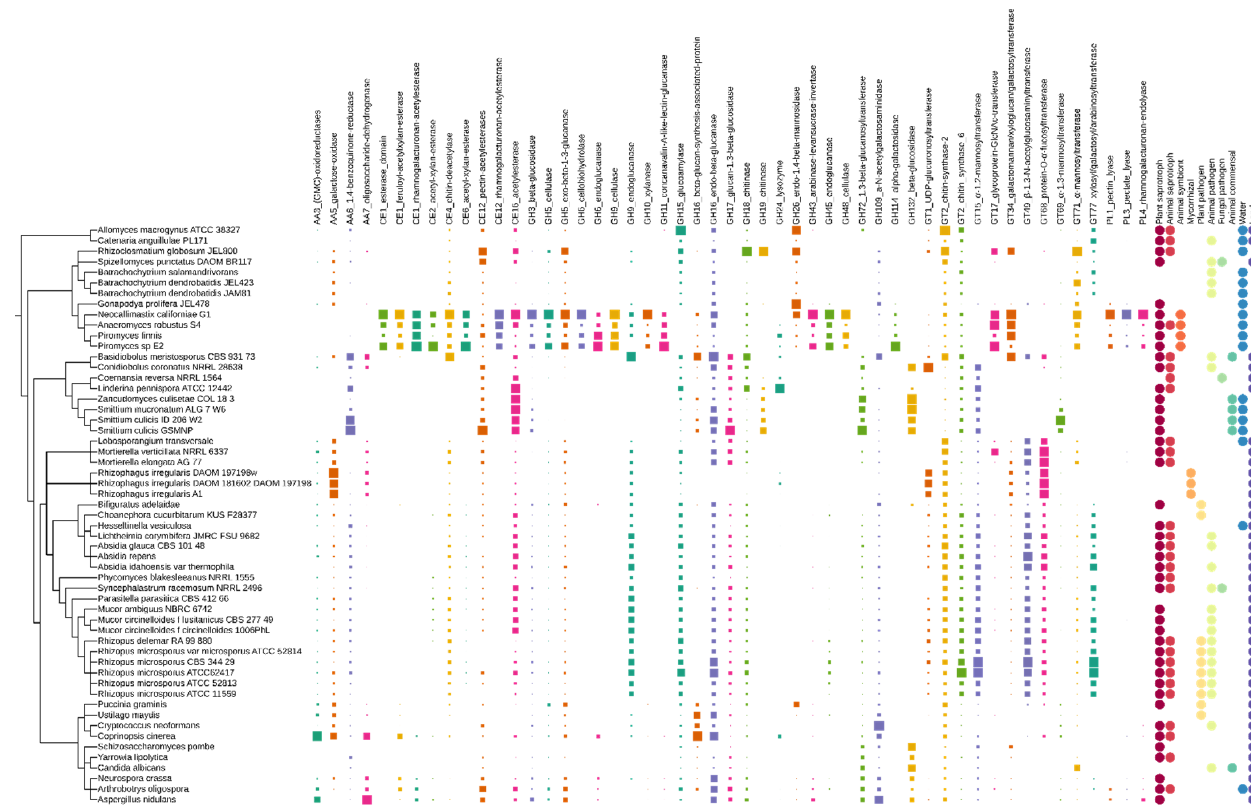
Figure 1. Distribution of adaptasome CaZymes within early-diverging fungi. The presence of proteins belonging to a particular family is marked with squares of size corresponding to their copy number. Fungal ecology features are shown as circles.